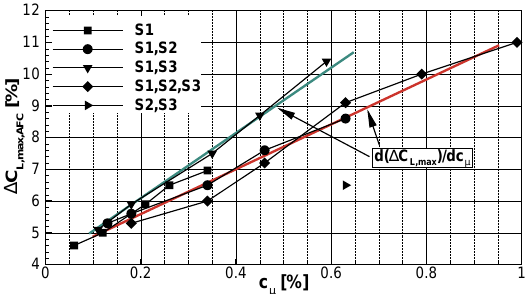
Figure 18. Maximum lift increase for different momentum coefficients and segment